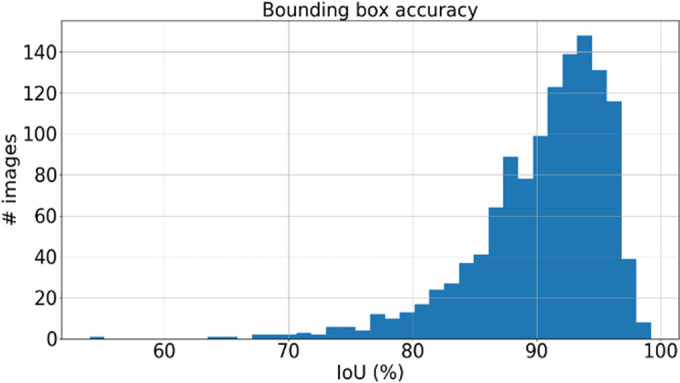
Example results from the localization network. (a) Intersection over union (IoU) of 53% and (b) IoU of 63% are the worst prediction results within the test set. (c, d) Typical prediction results. (e) Histogram shows the distribution of accuracy (IoU) throughout the test set.